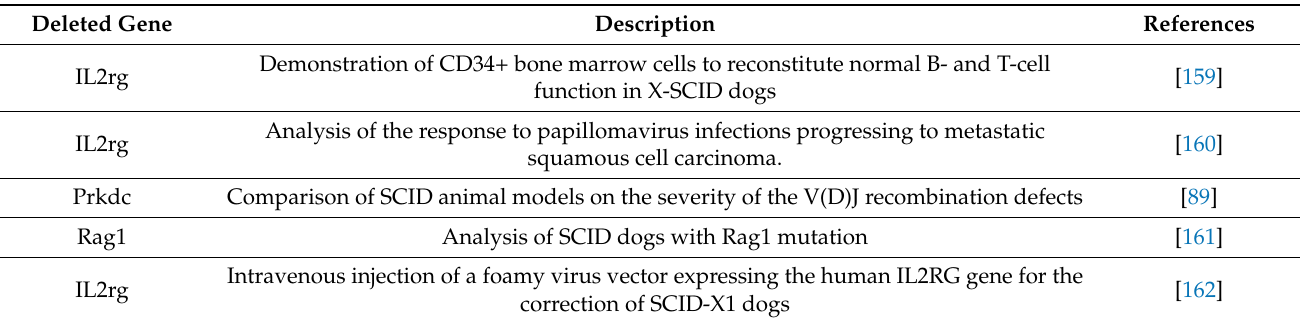
Table 3. Studies using SCID dogs.